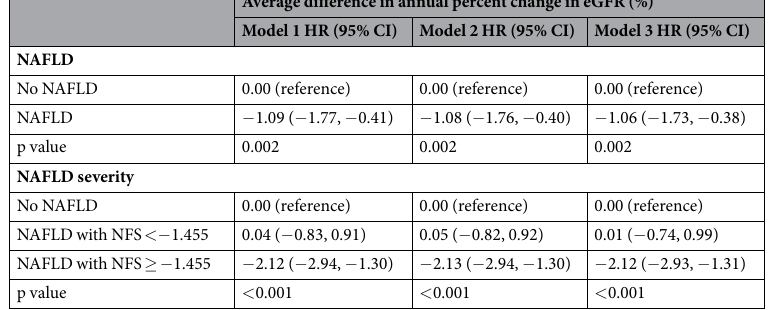
Table 2. Average difference in annual percent change in estimated glomerular filtration rate (eGFR) according to the presence and severity of nonalcoholic fatty liver disease (NAFLD) at baseline (n = 1,525). eGFR, estimated glomerular filtration rate; CI, confidence interval; NAFLD, non-alcoholic fatty liver disease; NFS, NAFLD fibrosis score. Model 1: Adjusted for age, sex, and year of visit Model 2: Further adjusted for baseline smoking status (never, former, current, and missing), alcohol intake (none and moderate), and body mass index. Model 3: Further adjusted for hypertension, diabetes, hyperlipidemia, systolic blood pressure, hemoglobin A1c, LDL cholesterol, and triglycerides (log e -transformed). For the NFS analyses, the models were not adjusted for age, body mass index, and diabetes as these factors are included in the calculation of the